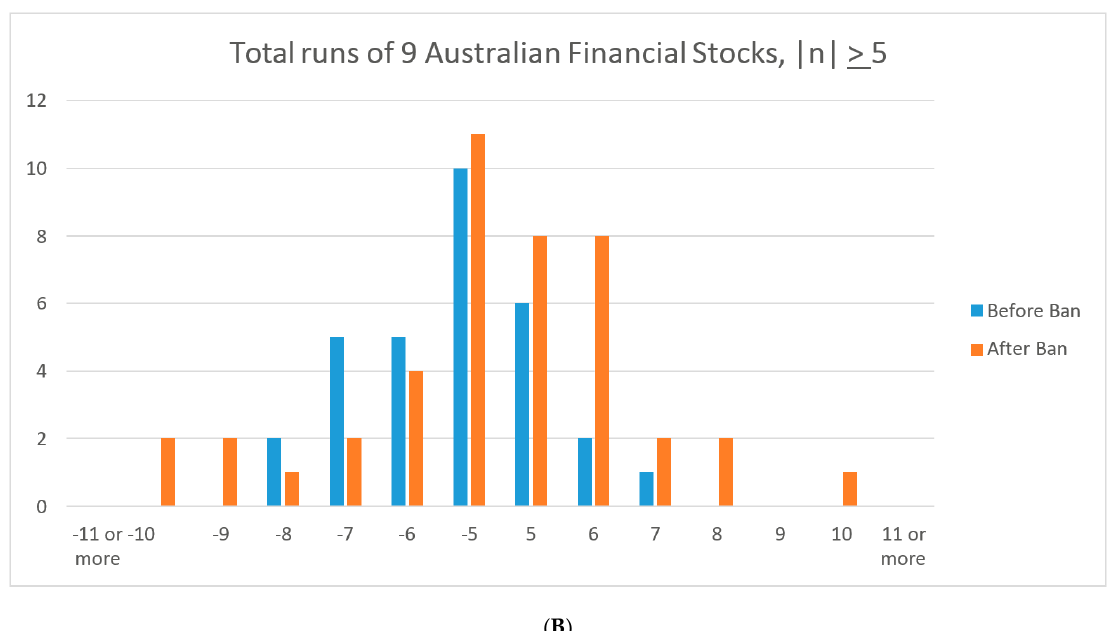
Figure 4. ( A ) Runs Distribution for Australian Stock Returns Before and After Short Selling Ban; ( B ) Tails of the Runs Distribution for Australian Stock Returns (|n| ≥ 5